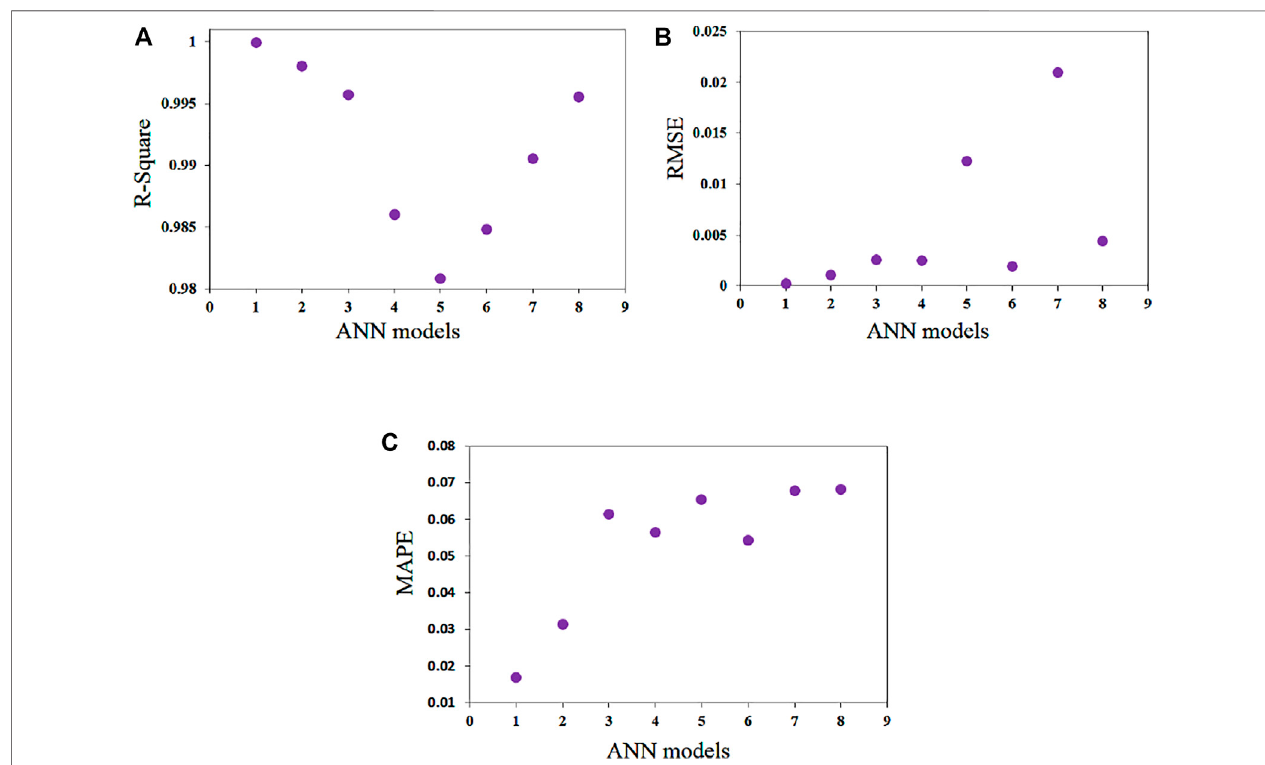
FIGURE 7 | (A) Training data and (B) testing data using regression analysis of predicted and experimental hardness.